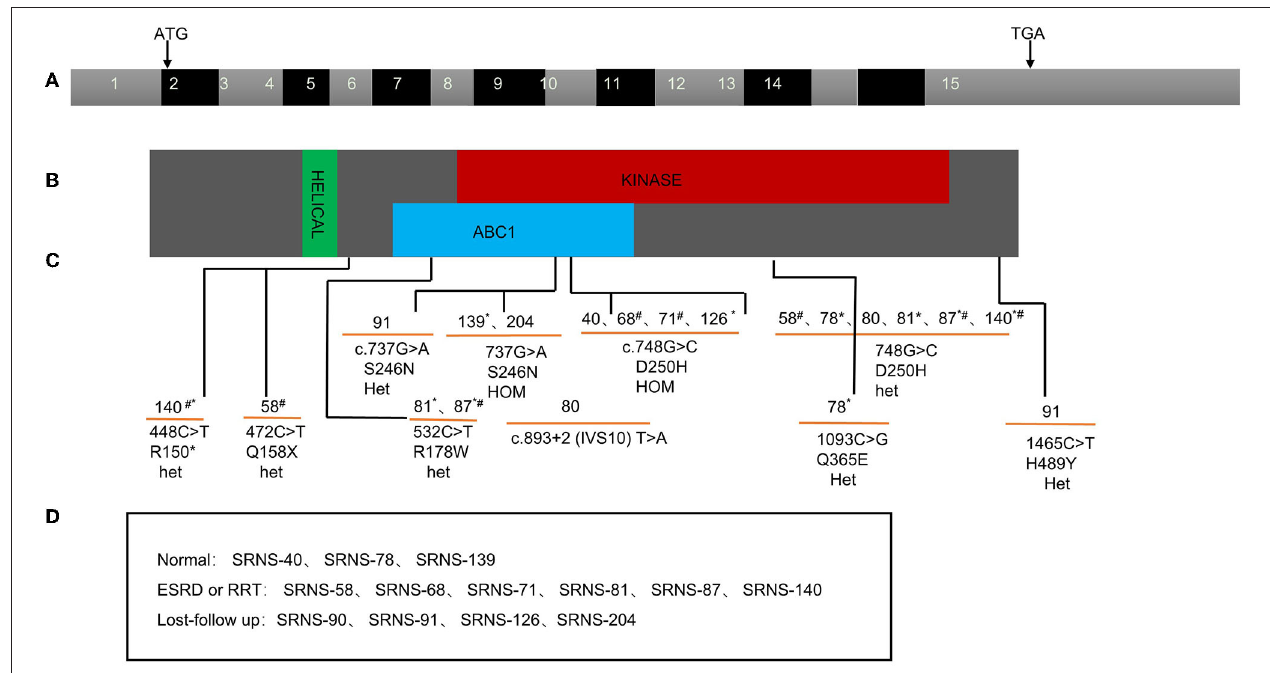
FIGURE 3 | ADCK4 mutation found in pediatric SRNS in China. Exon capture revealed ADCK4 mutations as causing SRNS and CNS. (A) Exon structure of human ADCK4 cDNA which contains 15 exons. Positions of start codon (ATG) and of stop codon (TGA) are noted. (B) Domain structure of the ADCK4 protein. Extent of predicted domains, helical, ABC1, and kinase is depicted by colored bars, in relation to encoding exon position. (C) 13 different ADCK4 mutations with SRNS or or early-onset nephrotic syndrome. (D) The renal outcome of the patients during the follow-up. *Family history of proteinuria; # Ending into ESKD or RRT during